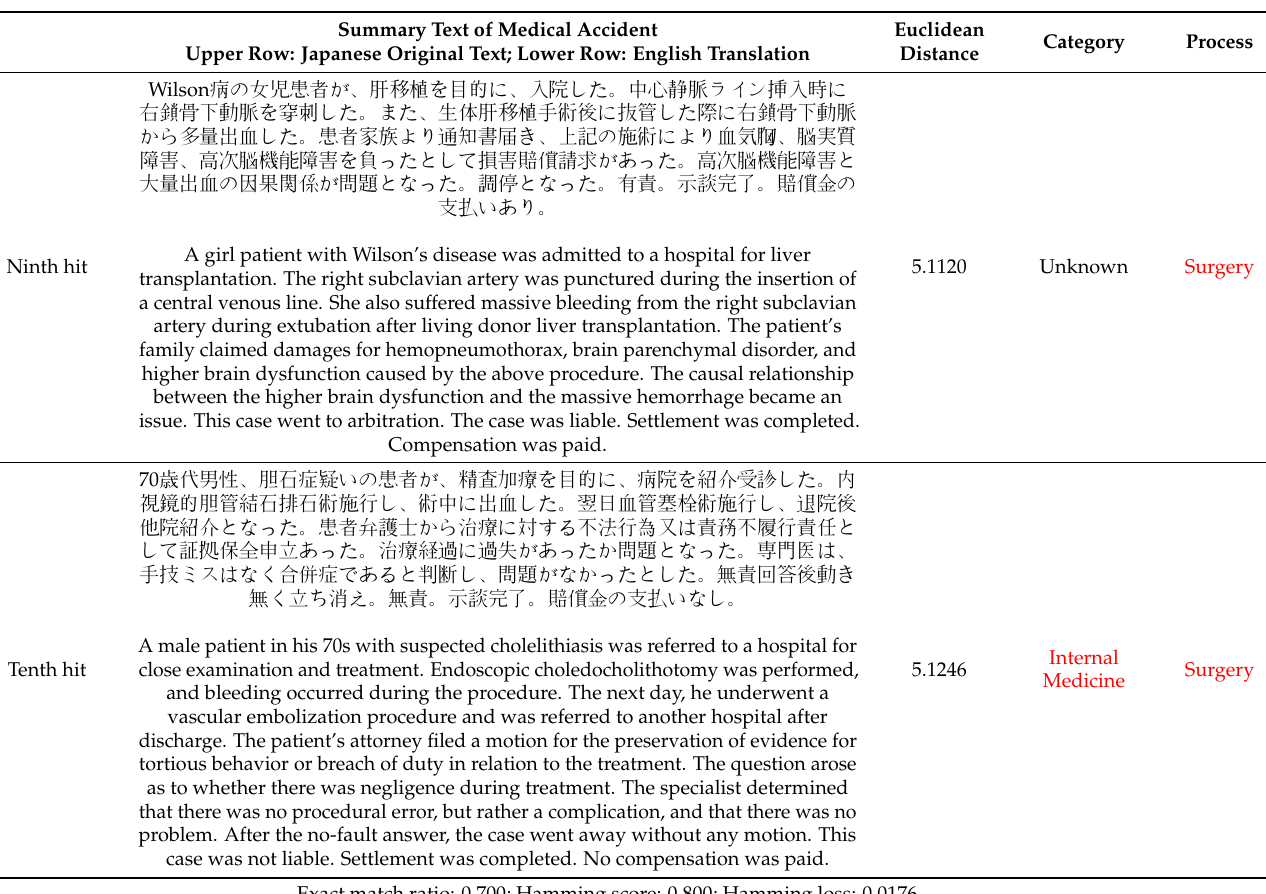
Table 5. Cont. Summary Text of Medical Accident Upper Row: Japanese Original Text; Lower Row: English